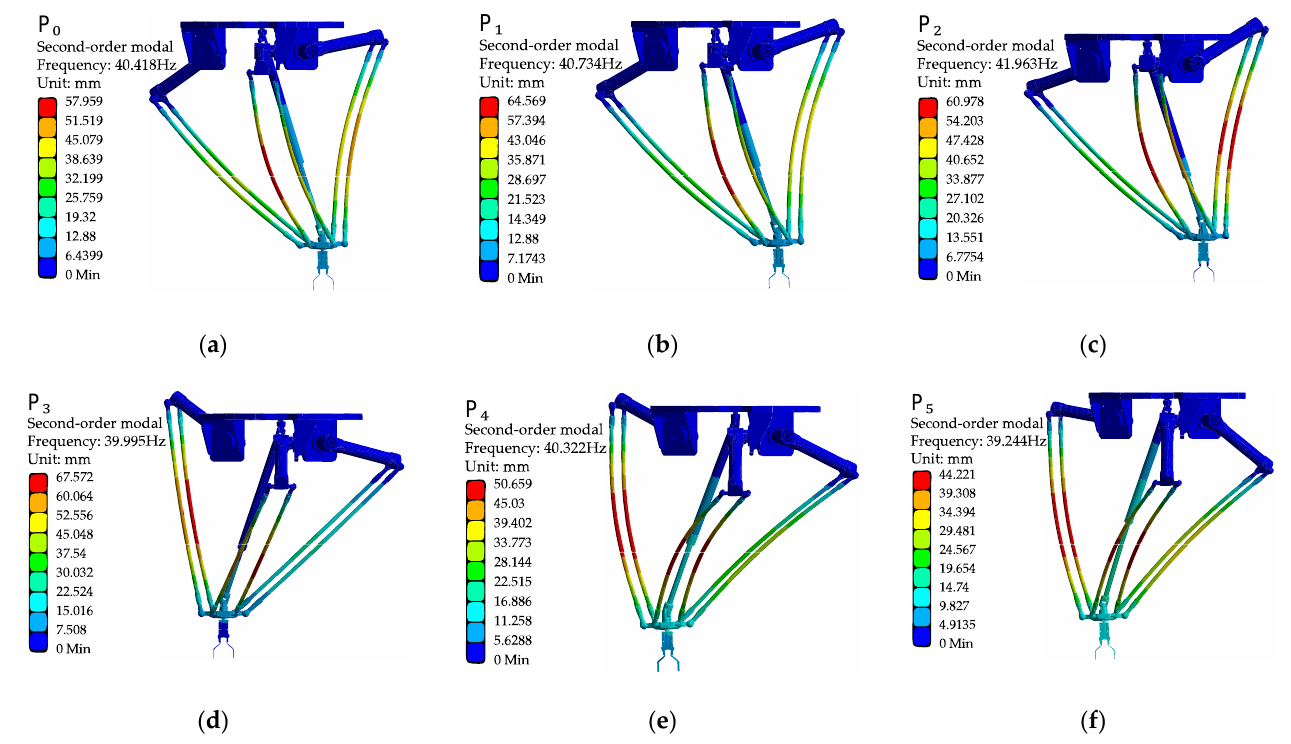
Figure 7. The second-order modal of each position point: ( a ) mode shape contour at point P 0 ; ( b ) mode shape contour at point P 1 ; ( c ) mode shape contour at point P 2 ; ( d ) mode shape contour at point P 3 ; ( e ) mode shape contour at point P 4 ; ( f ) mode shape contour at point P 5 .